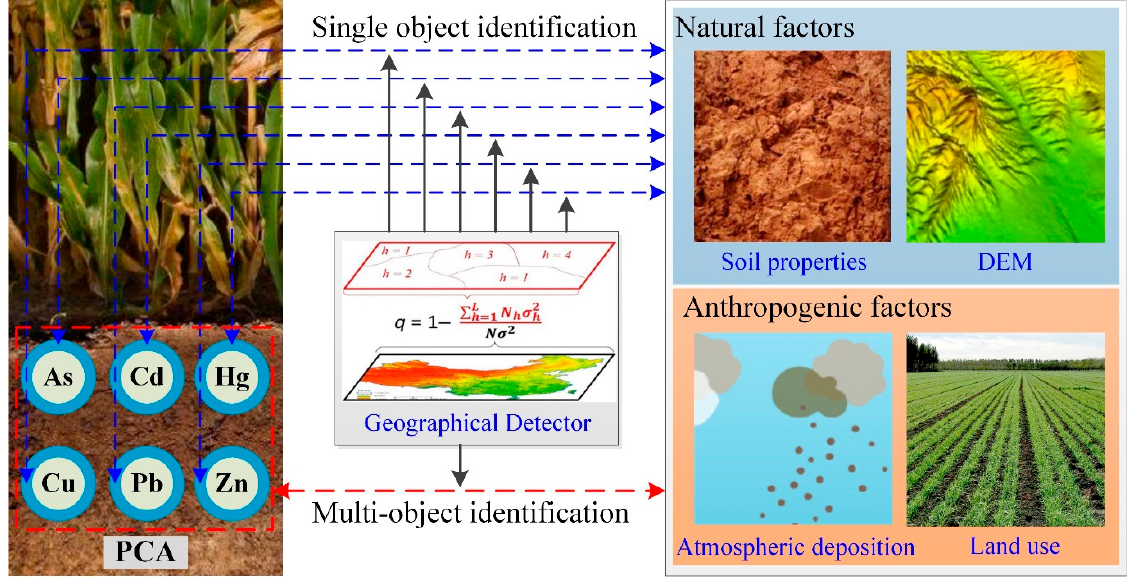
Figure 3. The proposed method for factor identification at a single-object and multi-object levels. The geographical detector is a spatial statistical method to test the relationships be- tween geographical phenomena and their potential influencing factors [22,23]. The geo- graphical detector quantifies the relative importance of an influencing factor on the heavy metal concentrations by power determinant ( q ). The q is defined as follows: